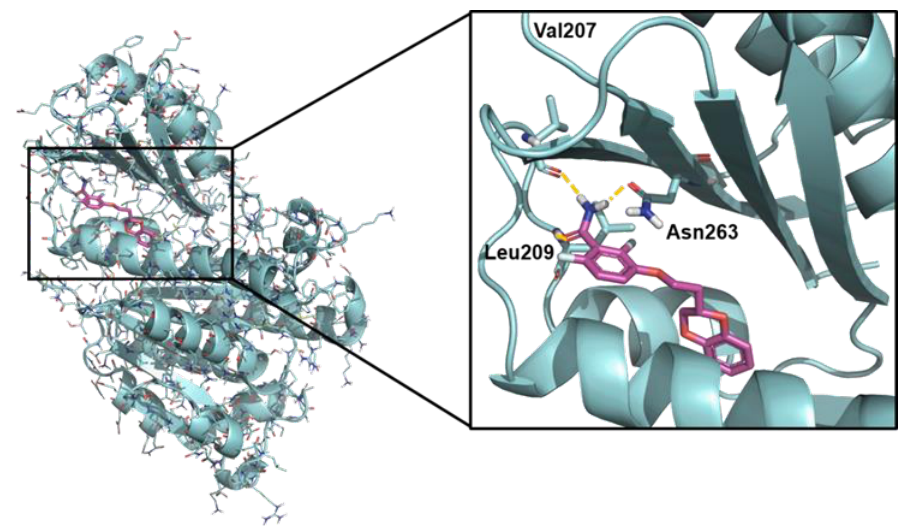
Figure 6. Docking results for compound 7 (depicted in pink) in the FtsZ protein (cyan), full protein view and detailed view of the binding site and main ligand-protein interactions.